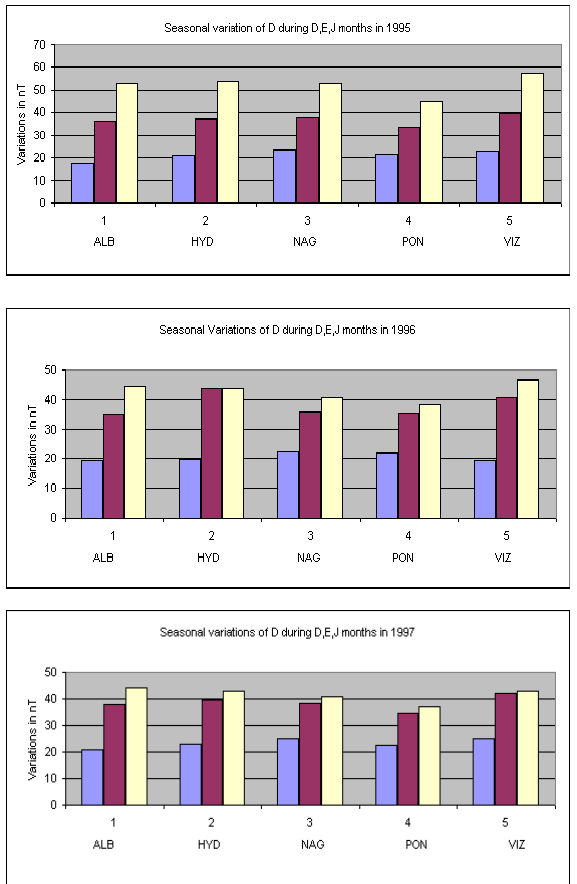
Fig. 2. Seasonal variations of the horizontal H-component during D, E, J